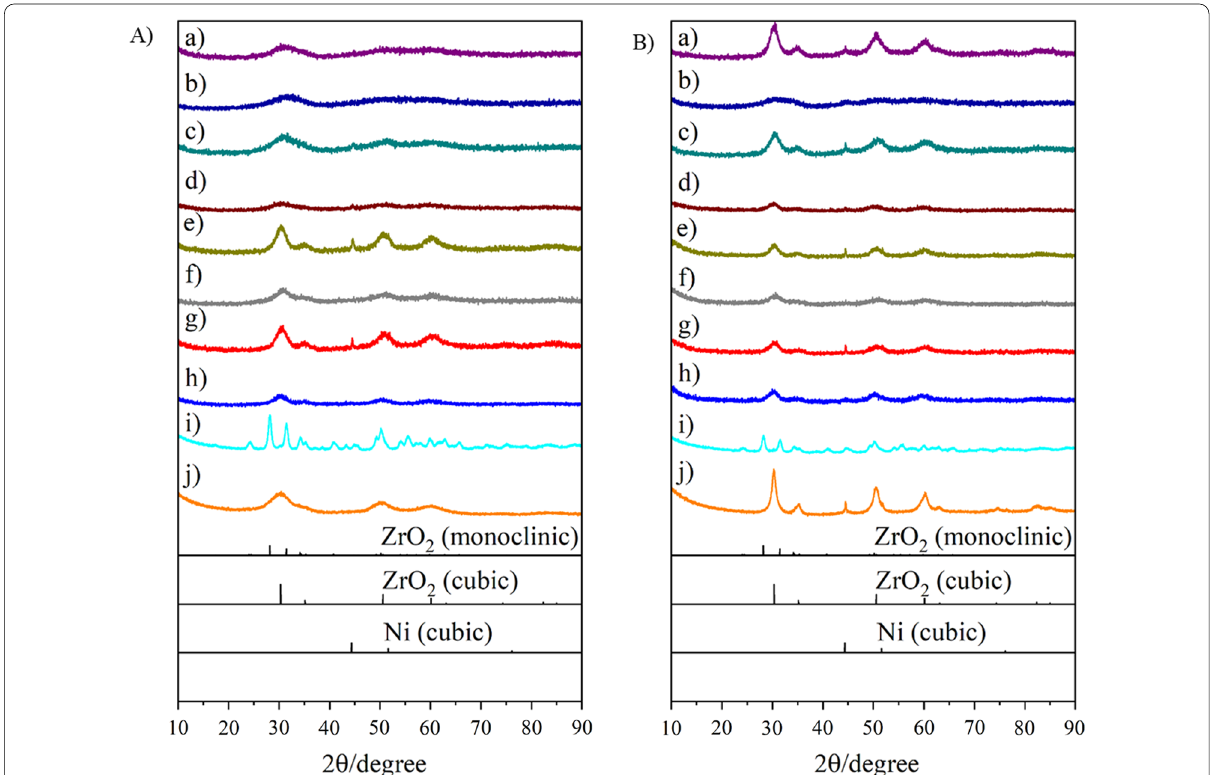
Fig. 4 XRD patterns of Ni catalysts embedded in ZrO 2 -based supports: a) L -Ni@ ZrO 2 , b) L -Ni@SiO 2 -ZrO 2 , c) L -Ni@MgO-ZrO 2 , d) L -Ni@Y 2 O 3 -ZrO 2 , e) S